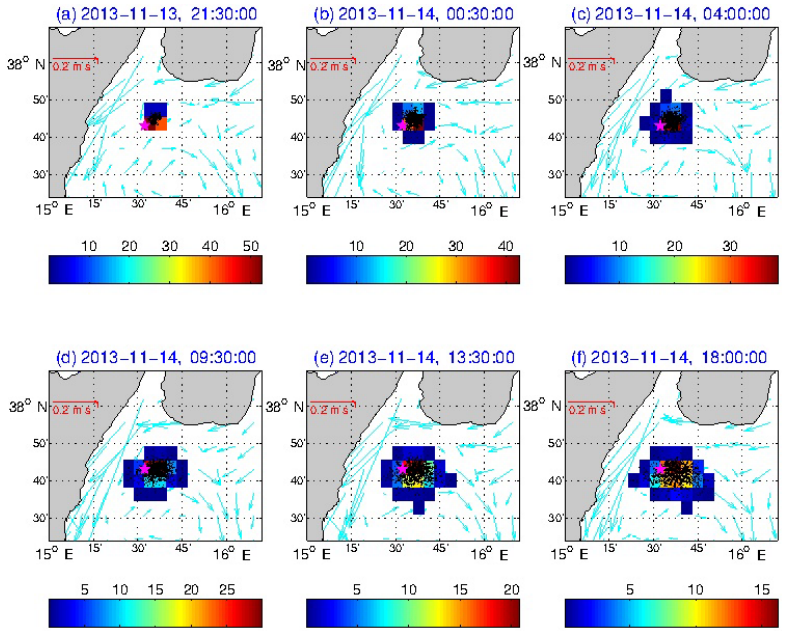
Figure 16. Particles’ cloud overlapped on the hydrodynamic field in the experiment executed in the Sicilian Channel. In (d) the configuration at the rescue time is visible. Far from the coast the current is prevalently eastward but the particles’ subset influenced by the current near the coast simulate the trajectory from the planting point to the rescue point/time